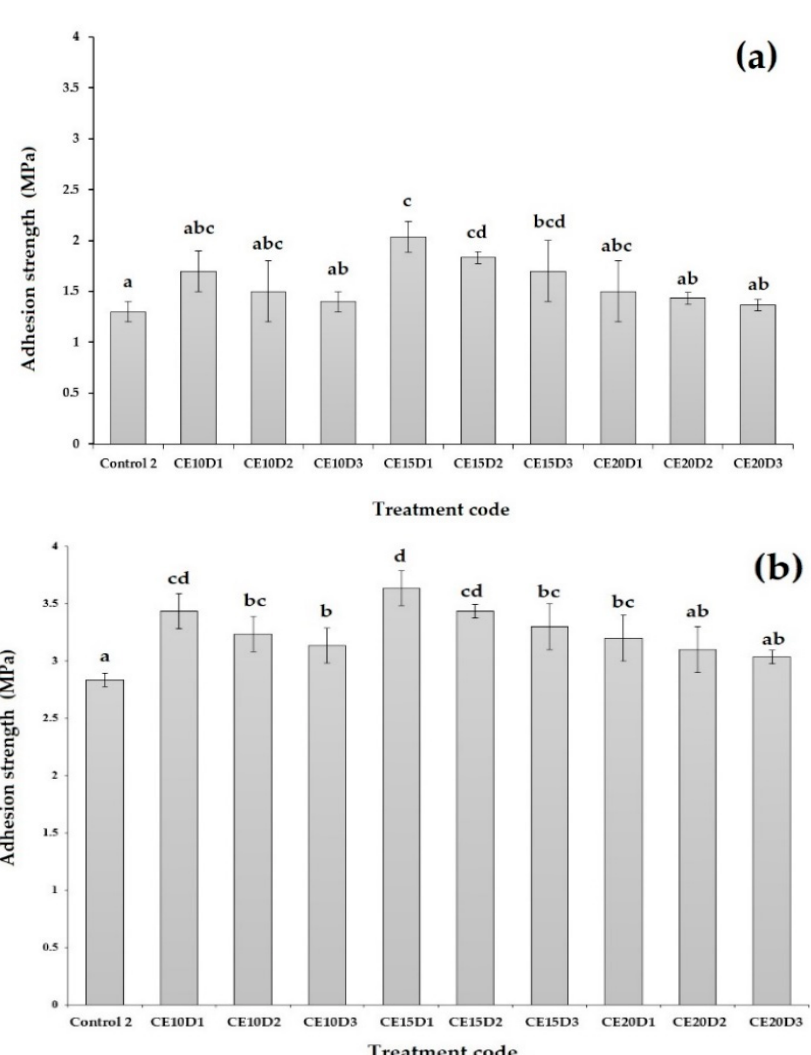
Figure 6. Adhesion strength of epoxy coatings on untreated and plasma-treated PB ( a ) and MDF ( b ). The statistical differences were tested with ANOVA and Duncan test, and the labelled values with the same letter were statistically equal at an error probability of α = 0.05. Error bars represent the standard deviations.